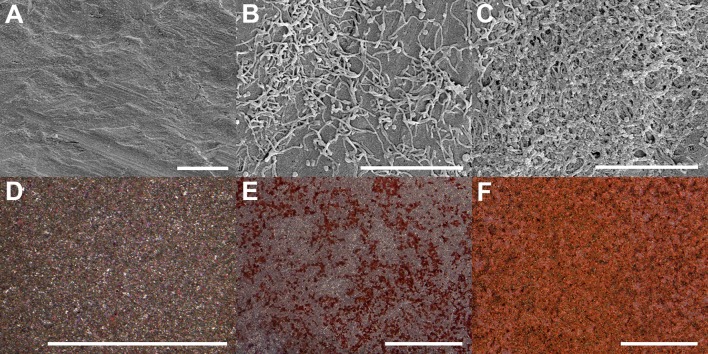
Surface morphology of Ti implants with and without collagen coatings visualized using SEM (A–C) and Sircol staining (D–F). (A,D) Ti substrate only. (B,E) Coating by adsorption. (C,F) Coating by atmospheric plasma. Scale bar = 5 μm (A–C) & 1 mm (D–F), respectively.